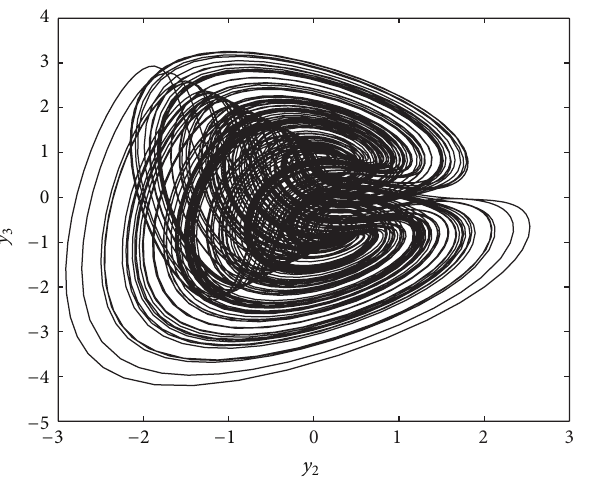
Figure 6: 𝑦 3 - V phase plane, the chaotic attractor.